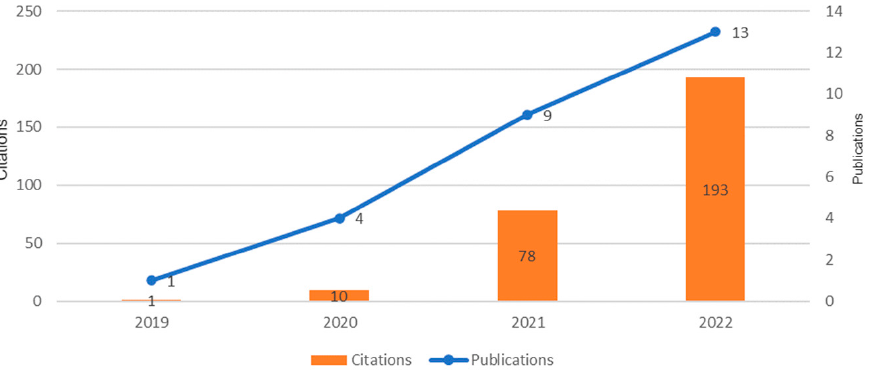
Figure 3. Times Cited and Publications Over